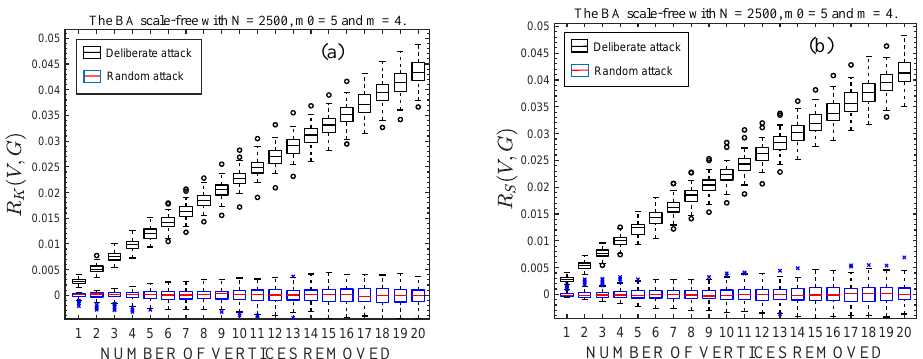
Figure 2. ( a , b ) respectively show the calculation and analysis of the R K ( V , G ) and R S ( V , G ) on the simulated BA scale − free network. By selecting 20 high − degree vertices for deliberate attacks and 20 random vertices for random attacks, they are all calculated by generating a 2500-order BA scale − free network with m 0 = 5 and m = 4 for 10 2 times, and the results are displayed in the form of box